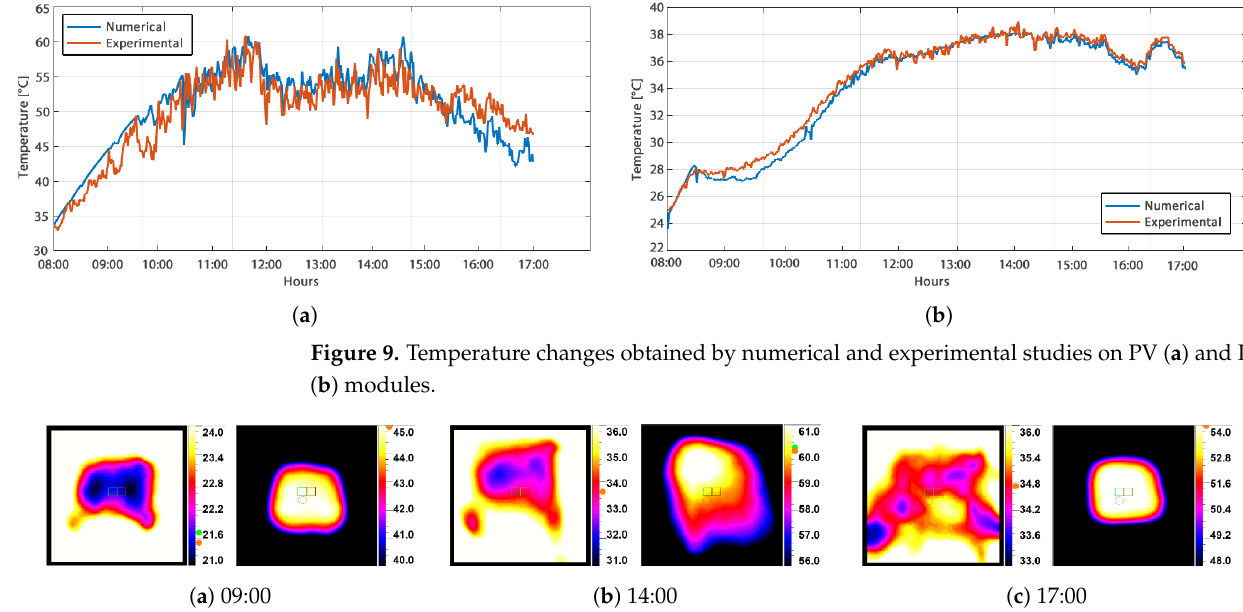
Figure 10. Temperature changes of the PV ( right ) and PV/T ( left ) modules which were taken by infrared